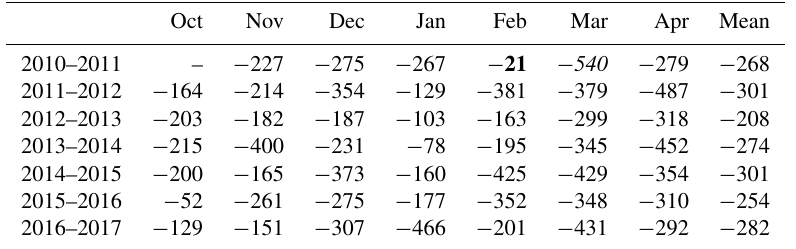
Table 2. Monthly Arctic sea ice volume export through the Fram Strait in km 3 month − 1 computed with OSI SAF ice drift. Maximum and minimum values are denoted in italic and bold, respectively. Oct Nov Dec Jan